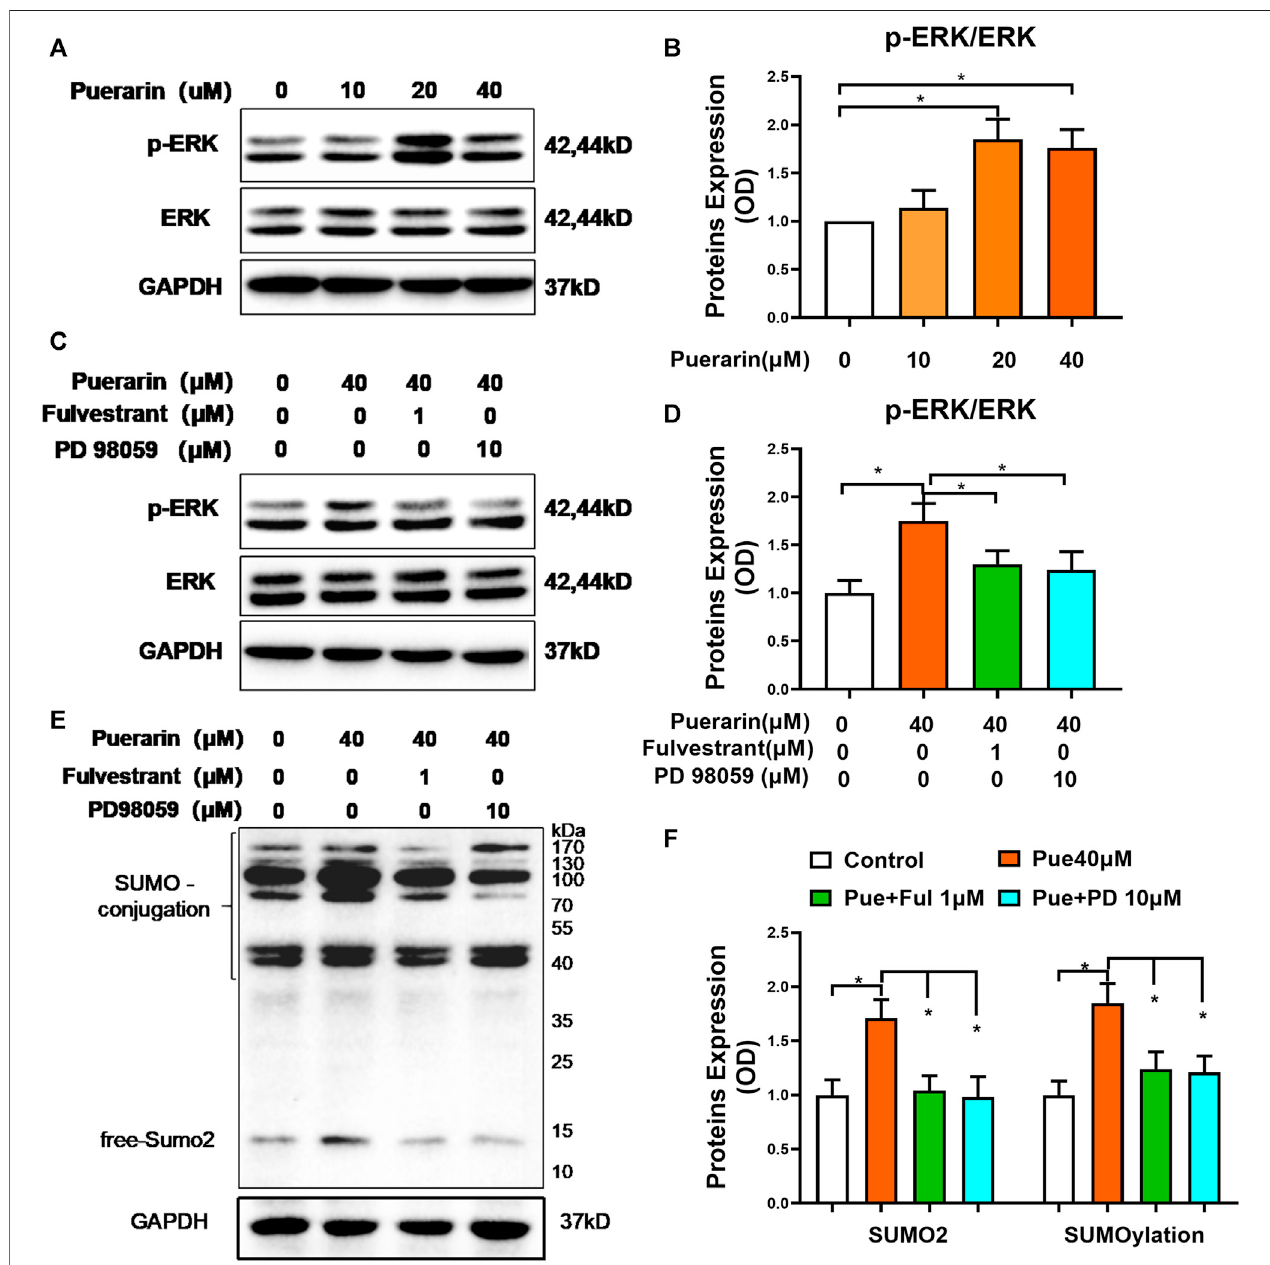
FIGURE 6 | Puerarin might up-regulate SUMO2 and SUMOylation via the ER/ERK pathway. (A) Western blot analysis of p-ERK and ERK levels. Following treatment with puerarin (10, 20, and 40 μ M) for 1 h, H9c2 cells were analyzed by Western blotting with antibodies against p-ERK and ERK. (B) Quanti fi cation of p-ERK and ERK expression. The results were shown asmean ± SD ( n (cid:2) 3). * p < 0.05. (C) Link of ERpathway toERK activation. Following treatment with puerarin-40 μ M alone or in combination with Fulvestrant-1 μ M and PD 98059-10 μ M for 1 h, H9c2 cells were analyzed by Western blotting with antibodies against p-ERK and ERK. (D) Quanti fi cation of p-ERK and ERK expression. The results were shown as mean ± SD ( n (cid:2) 3). * p < 0.05. (E) Western blot analysis for the role of ER pathway in the upregulationofSUMO2expressionandSUMOylation.Followingthetreatmentwithpuerarin-40 μ Maloneorincombinationwithfulvestrant-1 μ MorPD98059-10 μ Mfor 24 h,H9c2cellswerecollectedandanalyzedbyWesternblottingwithantibodiesagainstSUMO2. (F) Quanti fi cationofSUMO2expressionandSUMOylationinpanelE. The data were presented as mean ± SD ( n (cid:2) 3). * p < 0.05.